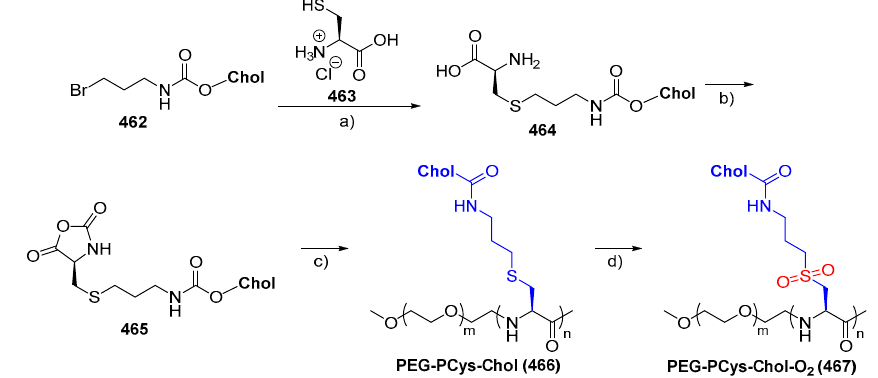
Scheme 108. Synthesis of copolymers PEG-PCys-Chol and PEG-PCys-Chol-O 2 . Reagents and